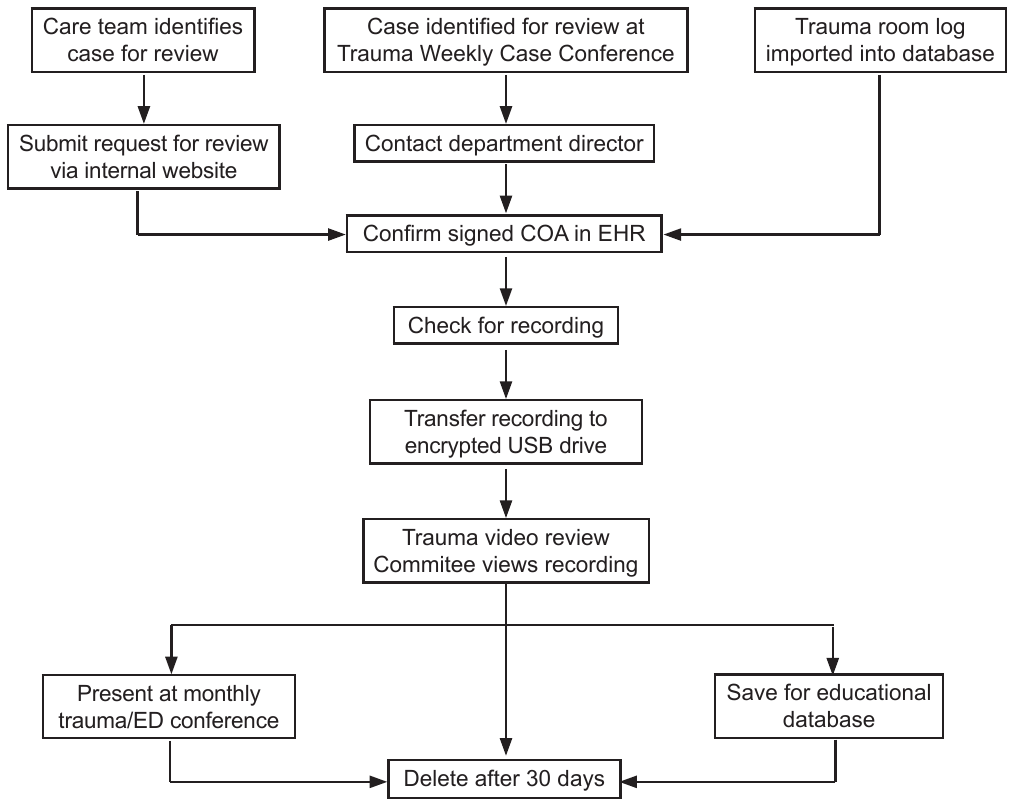
Figure. Our institutional video review